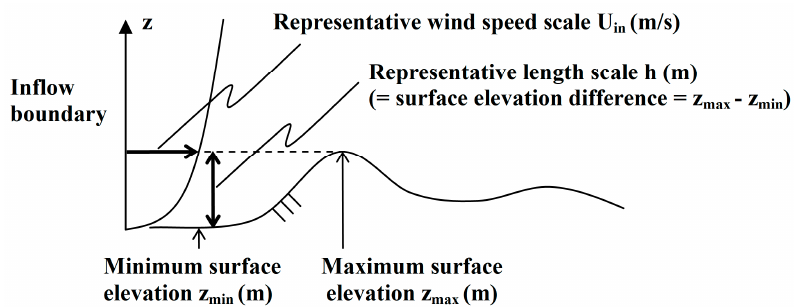
Figure 7. Representative scales used in the present study.